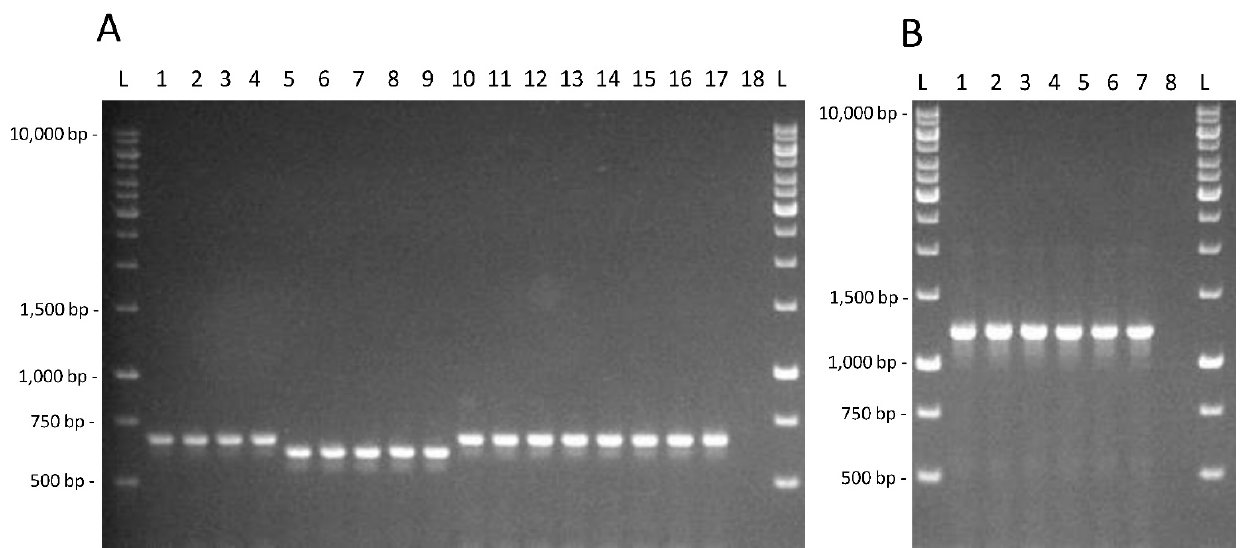
Figure 2. ( A ) Amplification products obtained for the tau B gene for strains L. casei AB-15-6 (1); C- 15-1 (2); C-15-1b (3); G-0-6 (4); L. paracasei AN-15-2 (5); AN-15-3 (6); J-7-1 (7); J-15-4 (8); P-7-13 (9); L. rhamnosus AN-7-4 (10); AN-21-1 (11); D-0-5 (12); G-7-14 (13); G-7-16 (14); J-7-4 (15); Z-15-4 (16); GG (17); negative control (18). ( B ). Amplification products obtained for the α -fucosidase LGG_02652